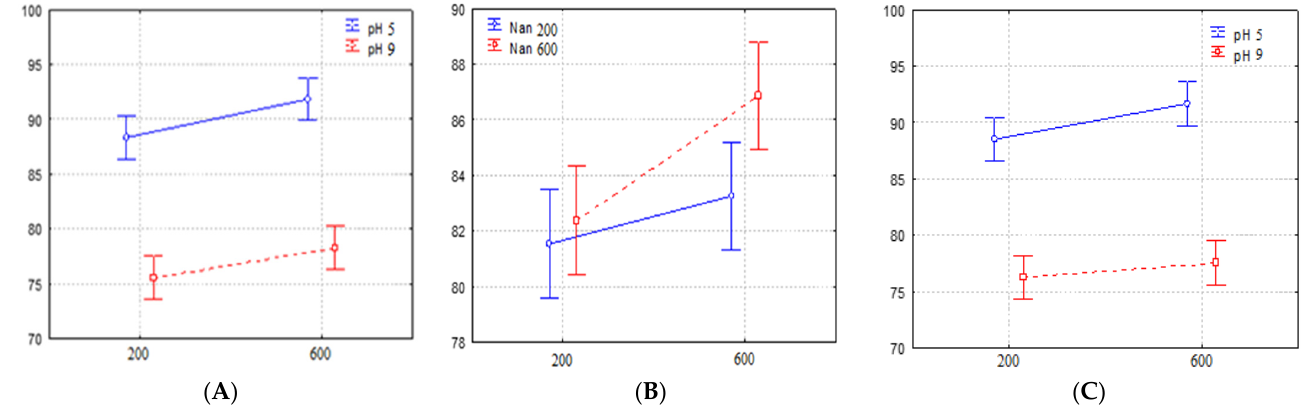
Figure 2. Effects of ( A ) second-order/volume × pH interaction; ( B ) second-order/volume × nanoparticle interaction; and ( C ) second-order/nanoparticle × pH interaction.